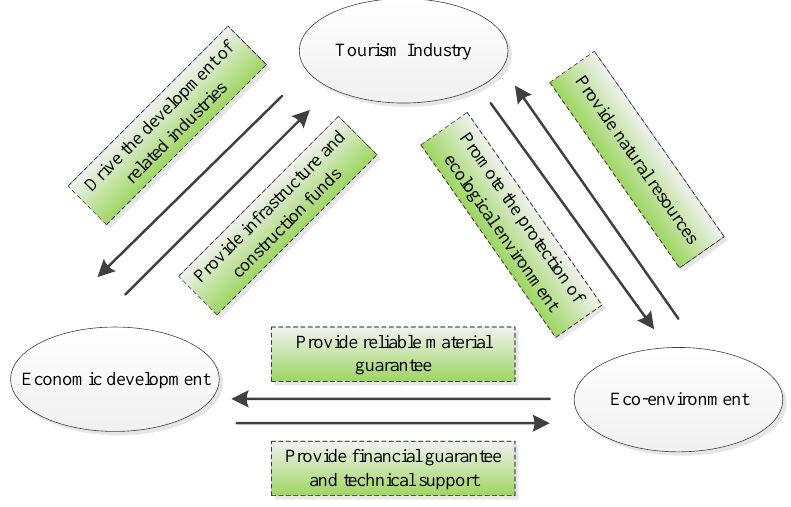
Figure 1. Coupling coordination mechanism of the TEE system.